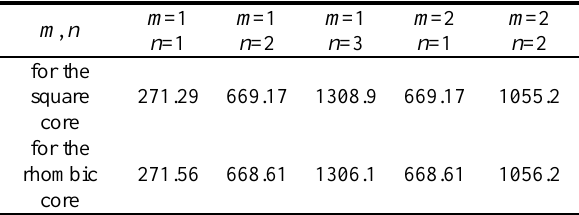
3. Natural freque